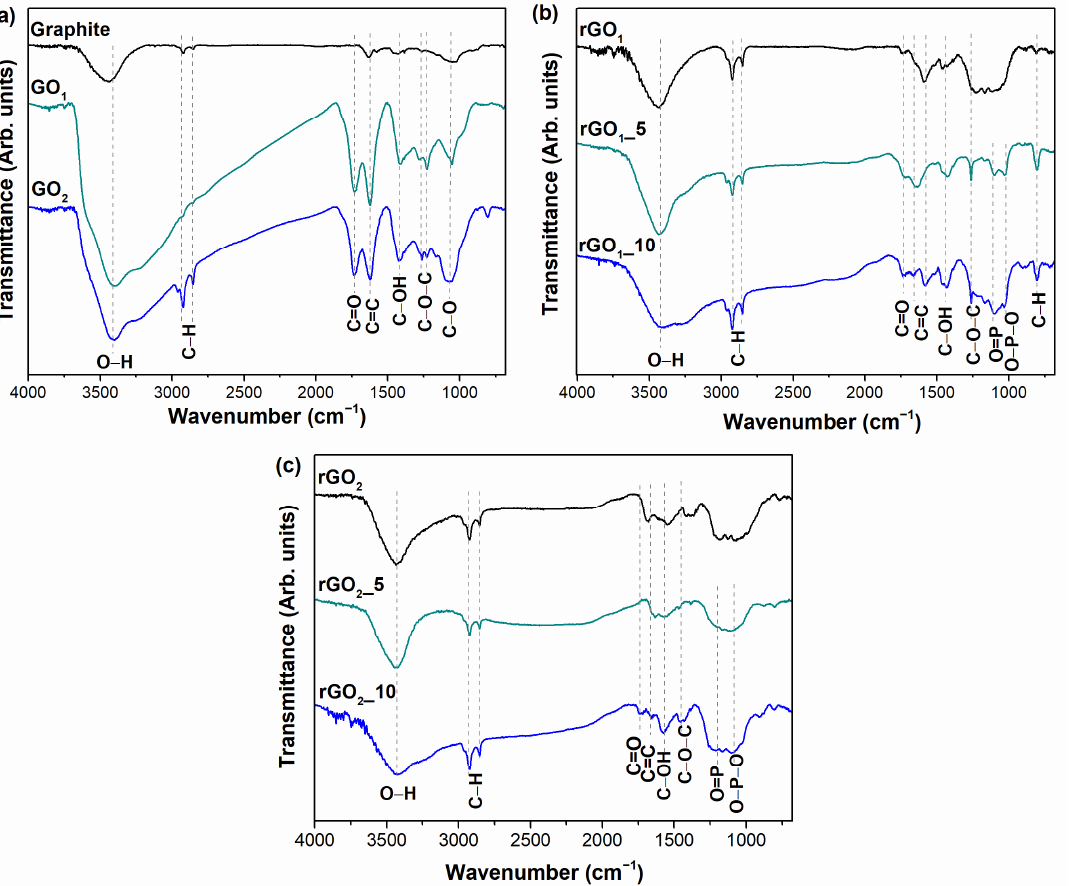
Figure 2. FTIR spectra of graphite, GO 1 , and GO 2 ( a ); thermally reduced samples derived from GO 1 ( b ); and thermally reduced samples derived from GO 2 ( c ). GO 1 ( b ); and thermally reduced samples derived from GO 2 ( c